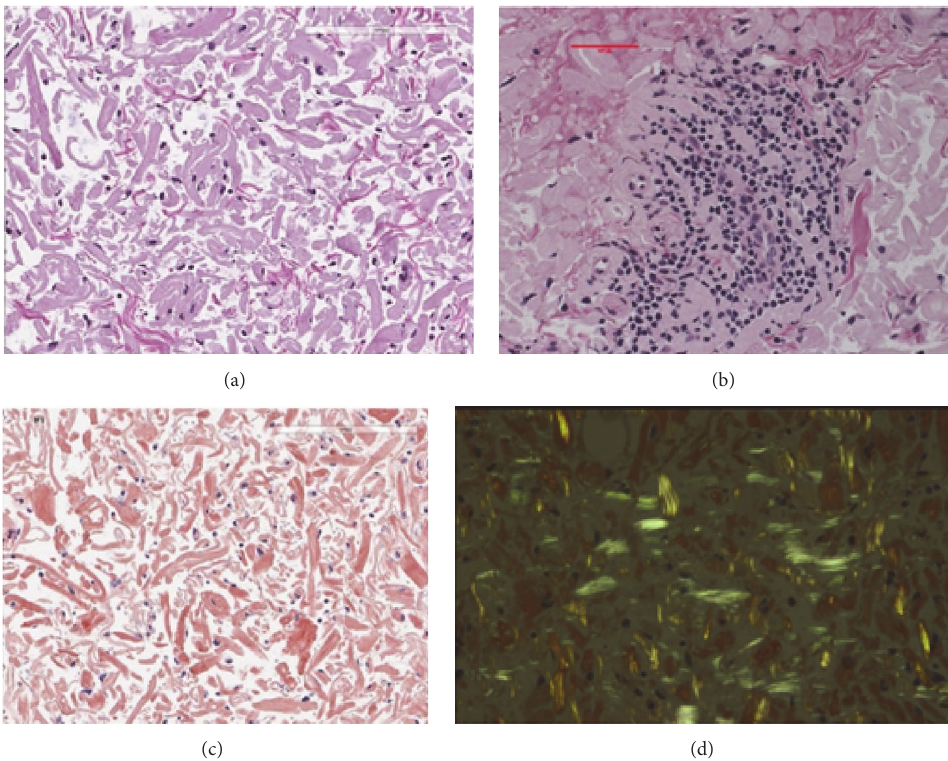
Figure 2: Representative histopathologic findings in the biopsy specimen of the mass in the subconjunctiva. (b) High magnification of H-E stained section showing an infiltration of inflammatory cells. (a) Lower magnification of H&E stained section showing an accumulation of amorphous, acellular eosinophilic material in the substantia propria of the conjunctiva. (c) Accumulated materials are direct fast scarlet (DFS) positive. (d) Polarized microscopy shows green birefringence and dichroism of amyloid fibers.